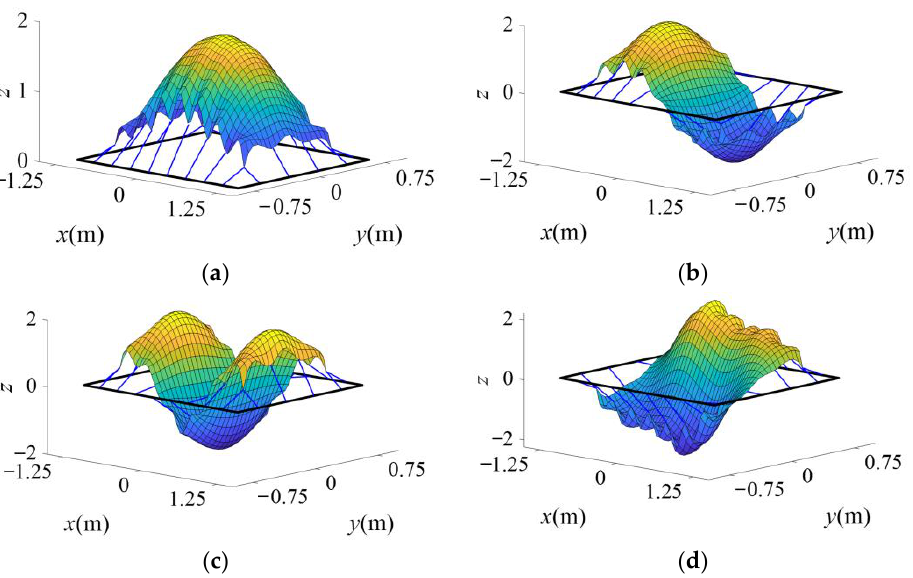
Table 2. Modal frequencies of the membrane antenna.